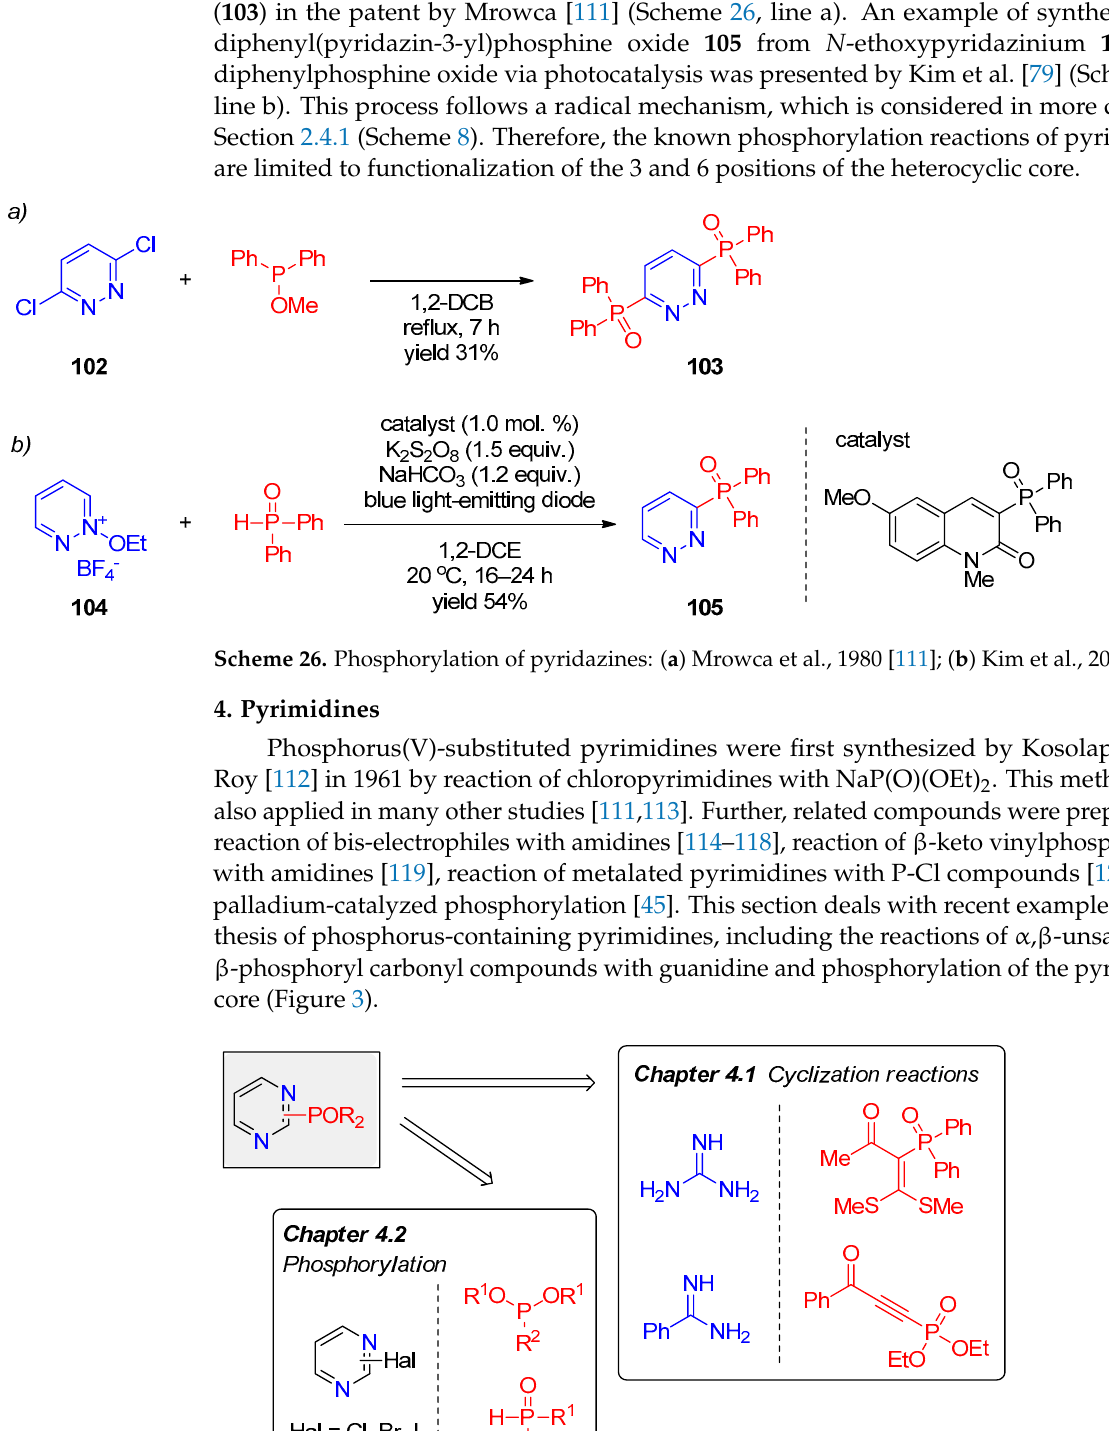
Figure 3. Approaches to synthesis of POR 2 -containing pyrimidines.